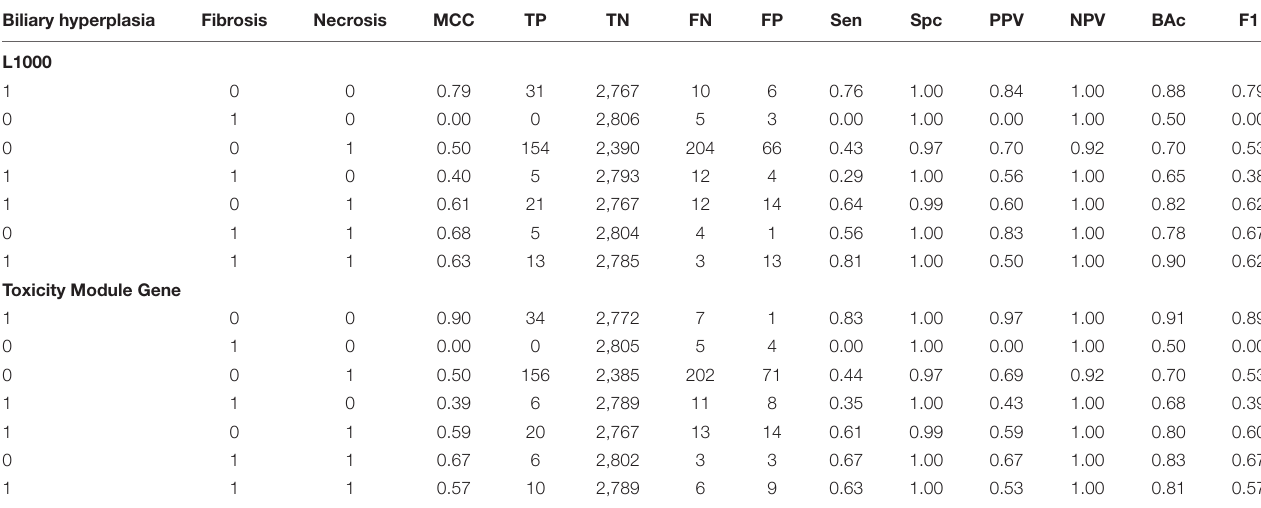
TABLE 6 | Metrics for three gene-level feature sets on combined cross validation data. Biliary hyperplasia